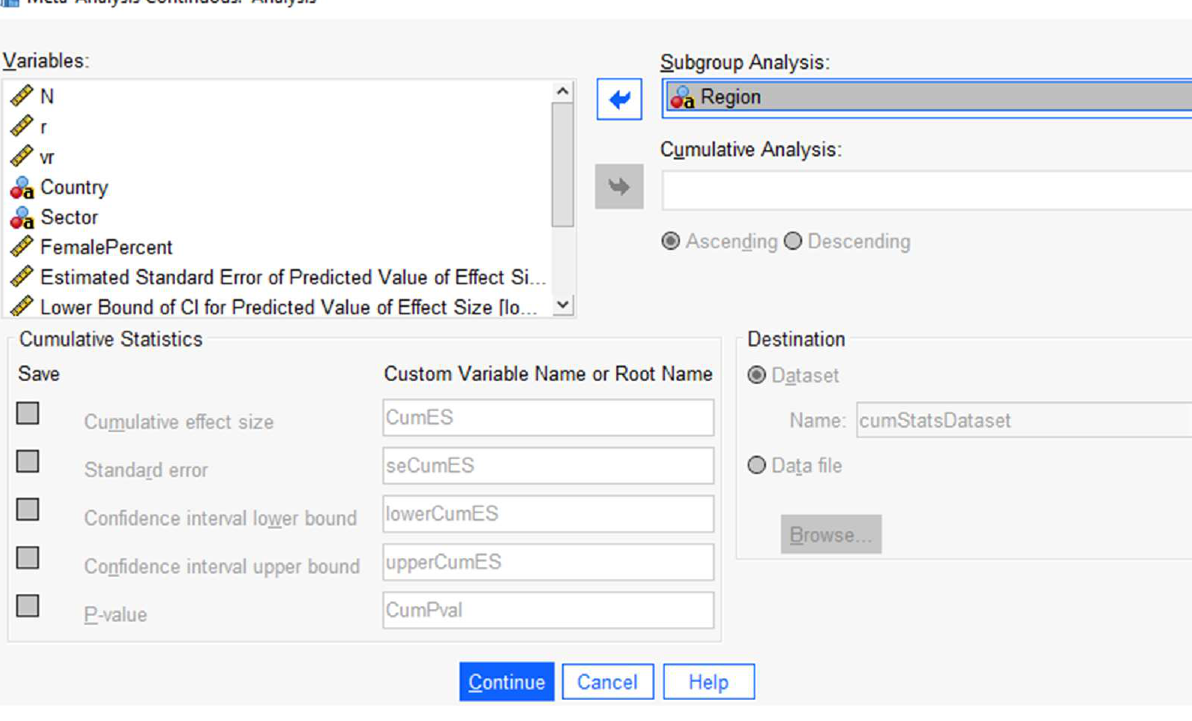
Figure 17. Subgroup Analysis Screen.